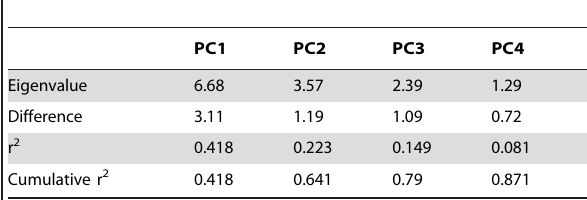
Table 6. Principal Component